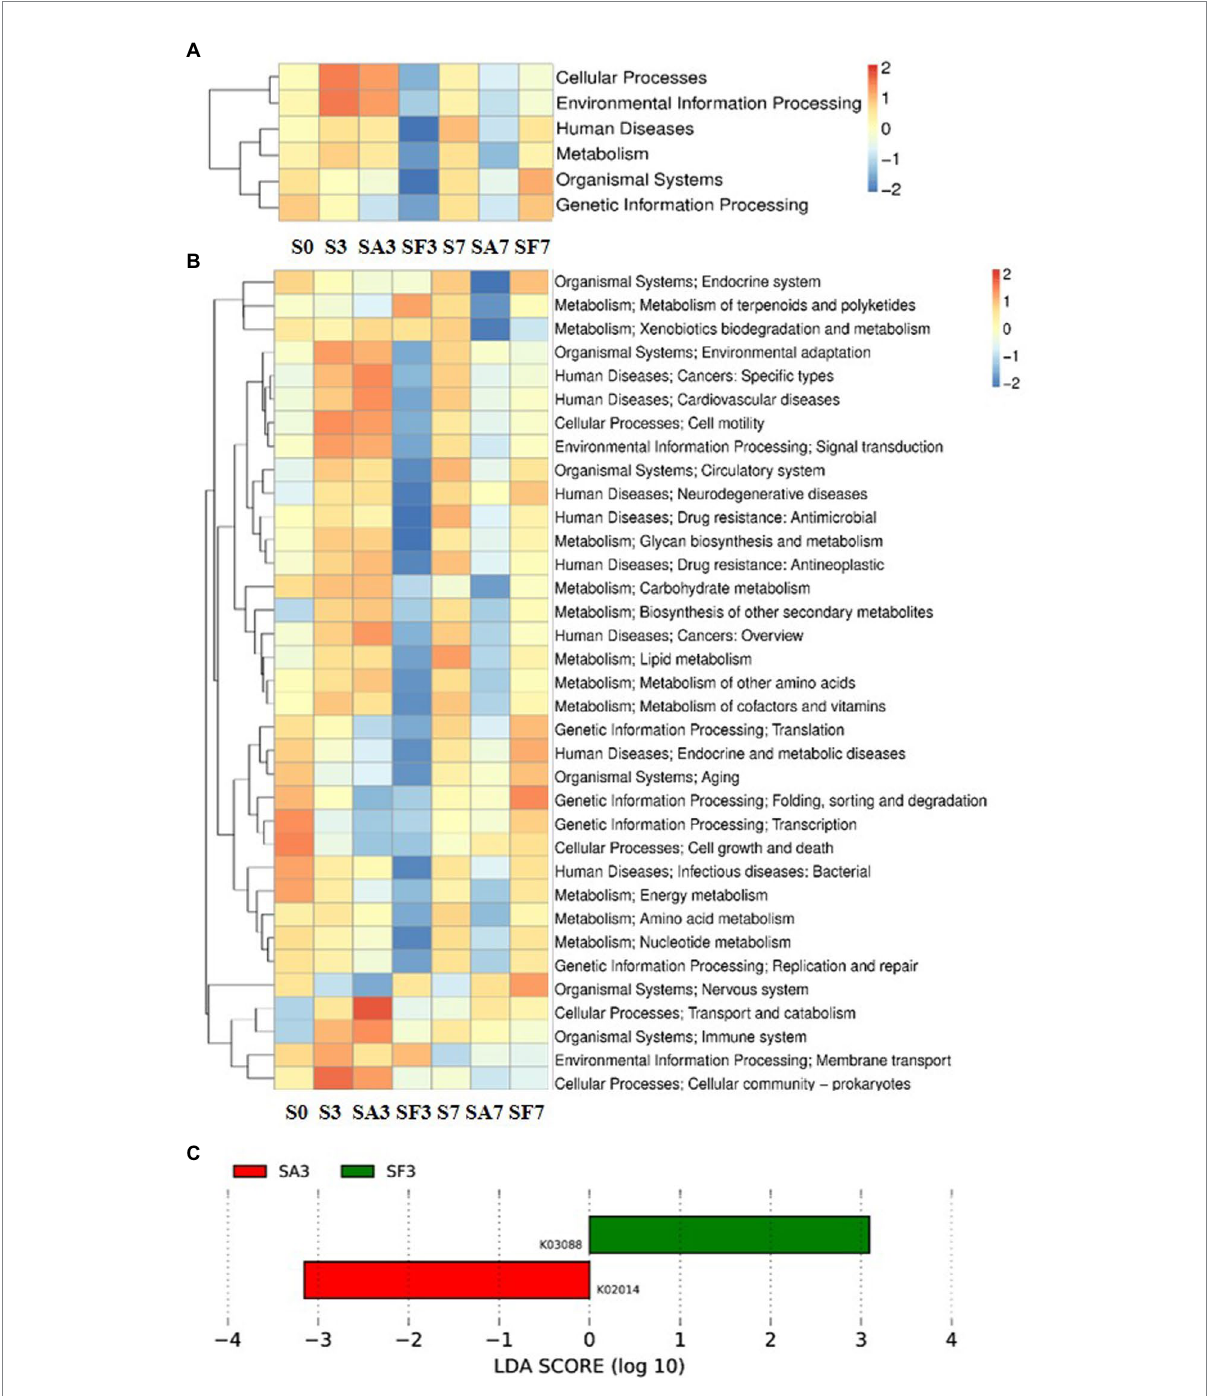
FIGURE 5 Functional diversity of the microbiomes among different soil samples based on KEGG pathways analysis (A) Heatmap of enrichment differences in six major metabolic pathways on level 1 among the samples. (B) Heatmap of enrichment differences in metabolic pathways on level 2 among the samples. The X -axis represents the sample group names; the Y -axis represents the KEGG metabolic pathway annotation information. (C) Distribution of linear discriminant analysis (LDA) scores between the SA3 and SF3 KEGG ortholog groups. S0, Mock-inoculation control, before treatment; S3, mock-inoculation control, 3 dpi; S7, mock-inoculation control, 7 dpi; SA3, SA + FON treatment, 3 dpi; SA7, SA + FON treatment, 7 dpi; SF3, FON treatment, 3 dpi; SF7, FON treatment, 7 dpi; FON, Fusarium oxysporum f. sp. niveum ; SA, salicylic acid; dpi, days